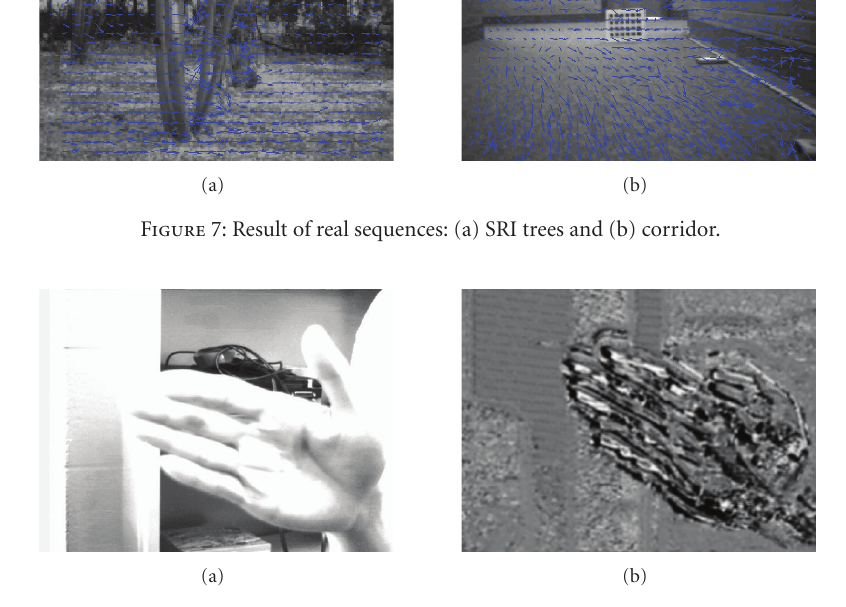
Figure 8: Real-time result from hardware: (a) original frame and (b) coded optical